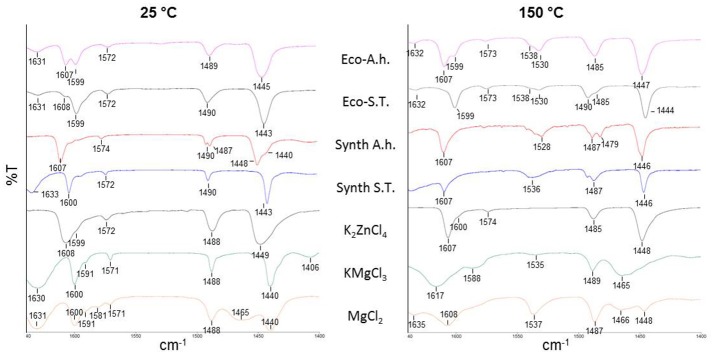
IR spectra of pyridine adsorbed on ecocatalysts (Eco-A.h. and Eco-S.T.), crystalline synthetic salts constitutive of ecocatalysts (Synth-A.h. and Synth-S.T.) and pure salts, recorded after outgassing at 25 and 150°C.